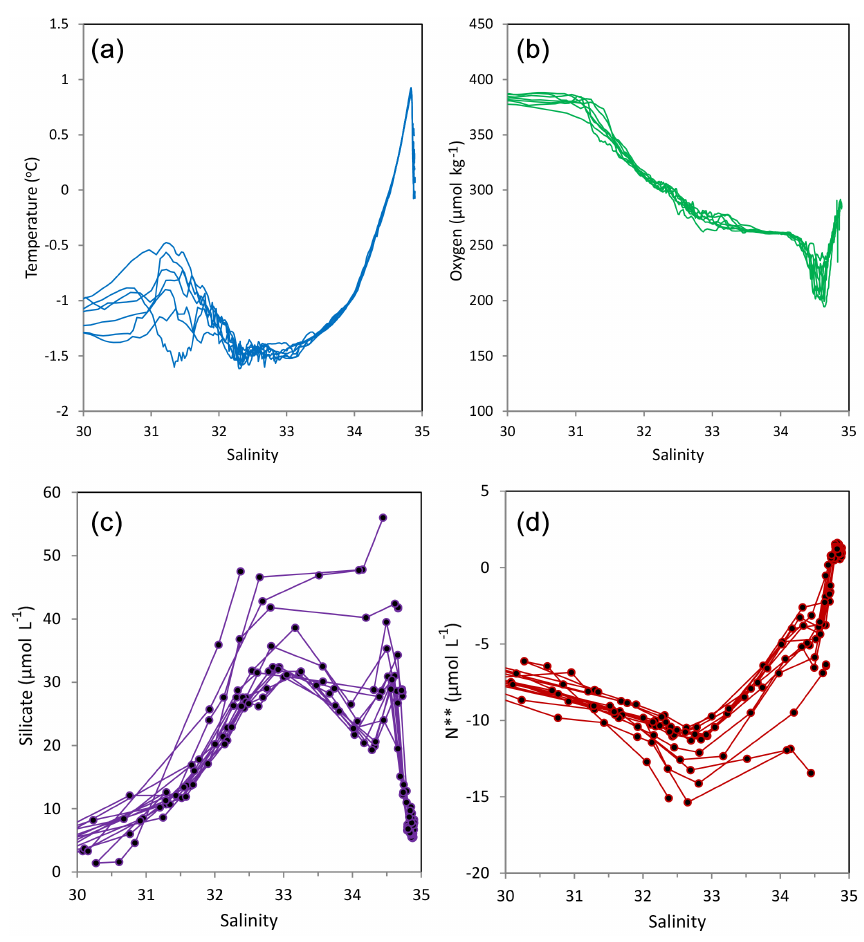
Figure 8. Temperature (a) , oxygen (b) , silicate (c) and N ∗∗ (d) versus salinity for the stations at sections D and E. The panels (a) and (b) are from the CTD output, while (c) and (d) are from water samples